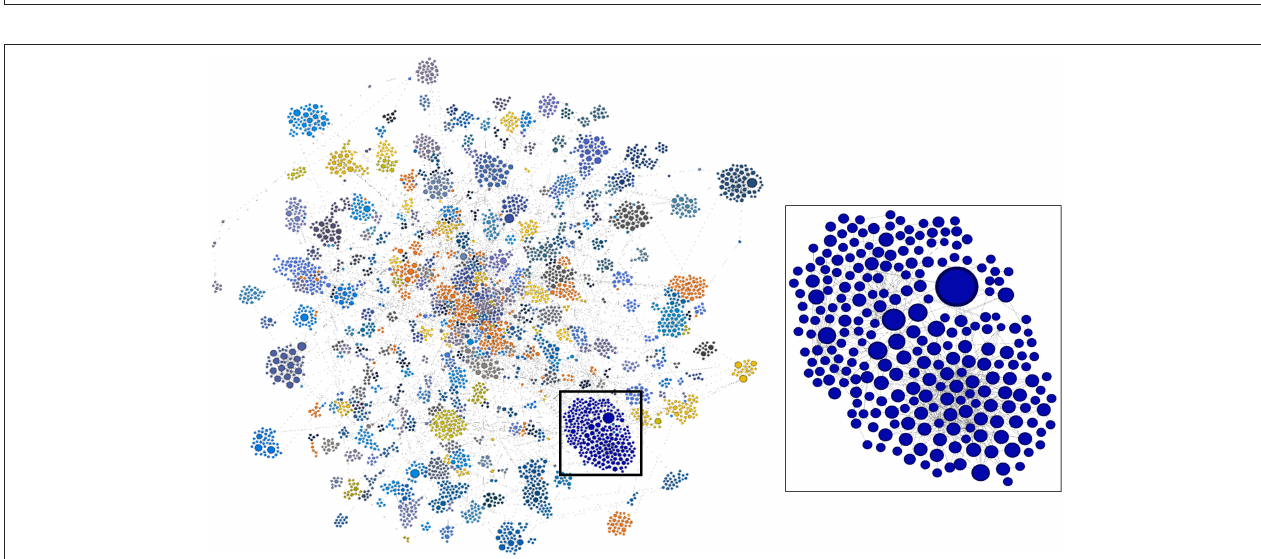
FIGURE 7 | Complete two-generation network as a directed graph. Highly linked clusters are identified by color. Blue cluster in box is enlarged at right. Visualization by Gephi.